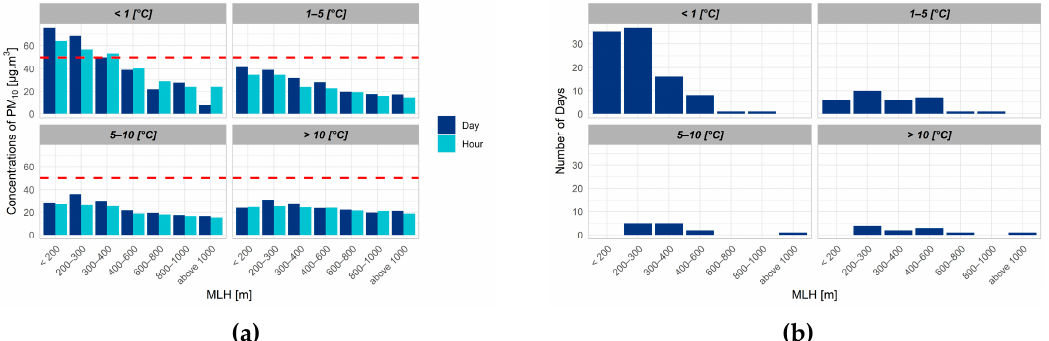
Figure 8. The T ř inec-Kosmos site, 2016–2019: ( a ) Average PM 10 concentrations depending on the mixing layer height and temperature; ( b ) Exceedance count of daily concentrations of 50 µg.m − 3 depending on the mixing layer height and temperature.